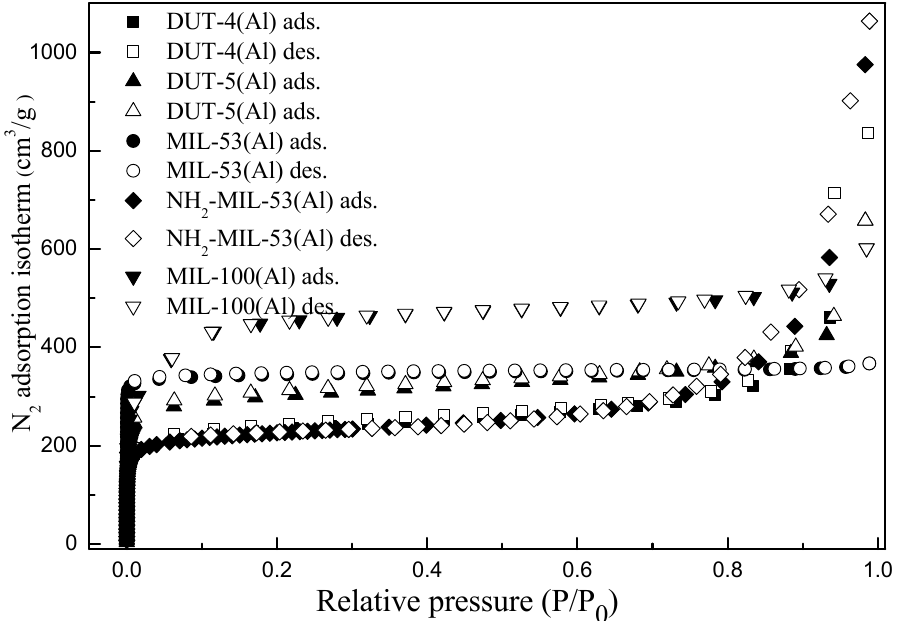
Figure 3. The N 2 gas sorption isotherms for: ( a ) DUT-4; ( b ) DUT-5; ( c ) MIL-53; ( d ) NH 2 -MIL-53; and ( e ) MIL-100.